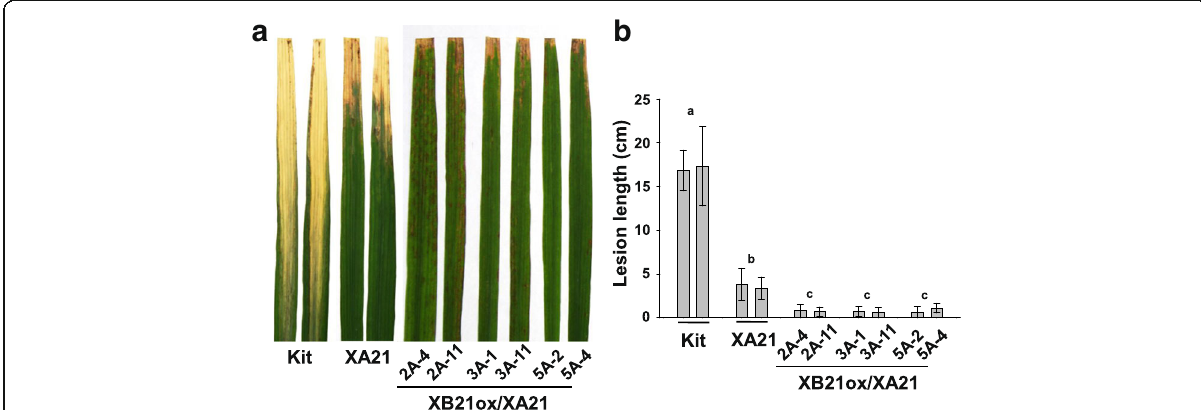
Fig. 4 XA21 transgenic rice plants overexpressing XB21 (XB21ox/XA21) confer enhanced resistance to Xoo. a Rice plants 12 days after inoculation with Xoo . From left to right: Transgenic lines carrying XB21ox construct (XB21ox/XA21), transgenic line (XA21, 23A-1-14) carrying XA21 driven from its native promoter, and Kitaake wild type (Kit). b Lesion lengths of Xoo inoculated plants of transgenic lines carrying XB21ox construct (XB21ox/ XA21), transgenic line (XA21) carrying XA21 driven from its native promoter, and Kitaake wild type